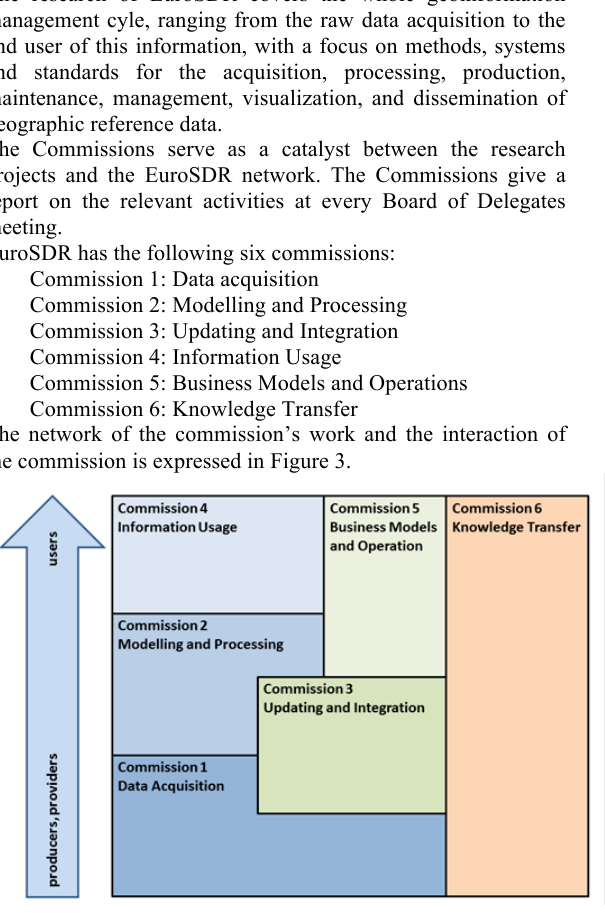
Figure 3. Network of the commission’s work and